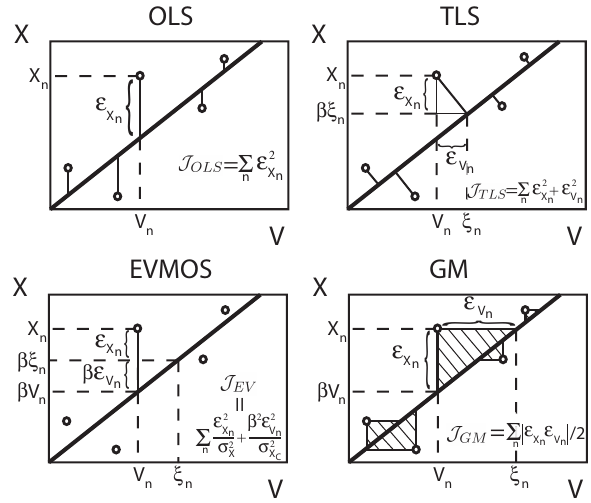
Fig. 1. Illustration of the cost functions J associated with four different regression methods (OLS, TLS, EVMOS and GM) in the case of one predictor. The dots are data points which associate each forecast point V n to a corresponding measured value X n . The black line is the regression line X C = βV